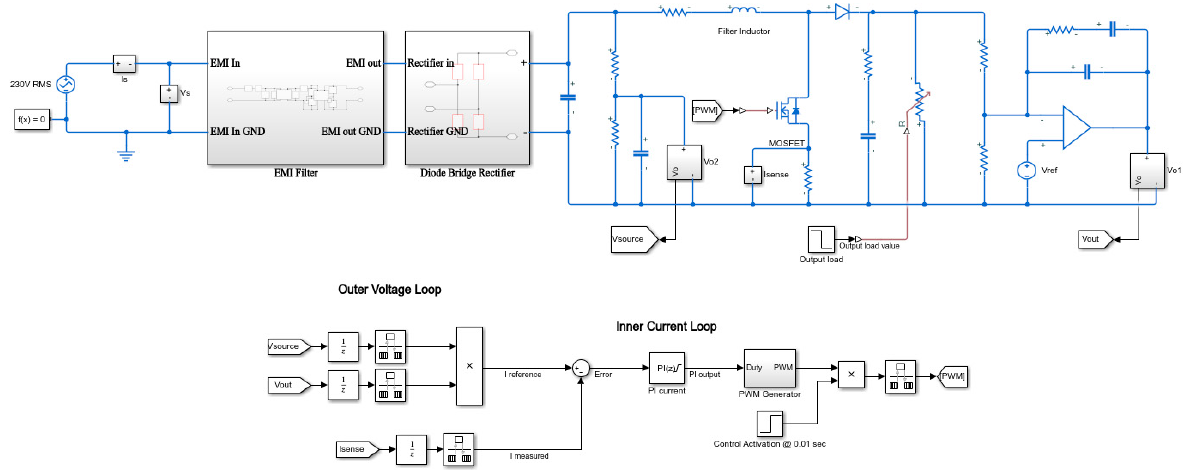
Figure 9. Simulink model of the boost PFC converter with the control loops.